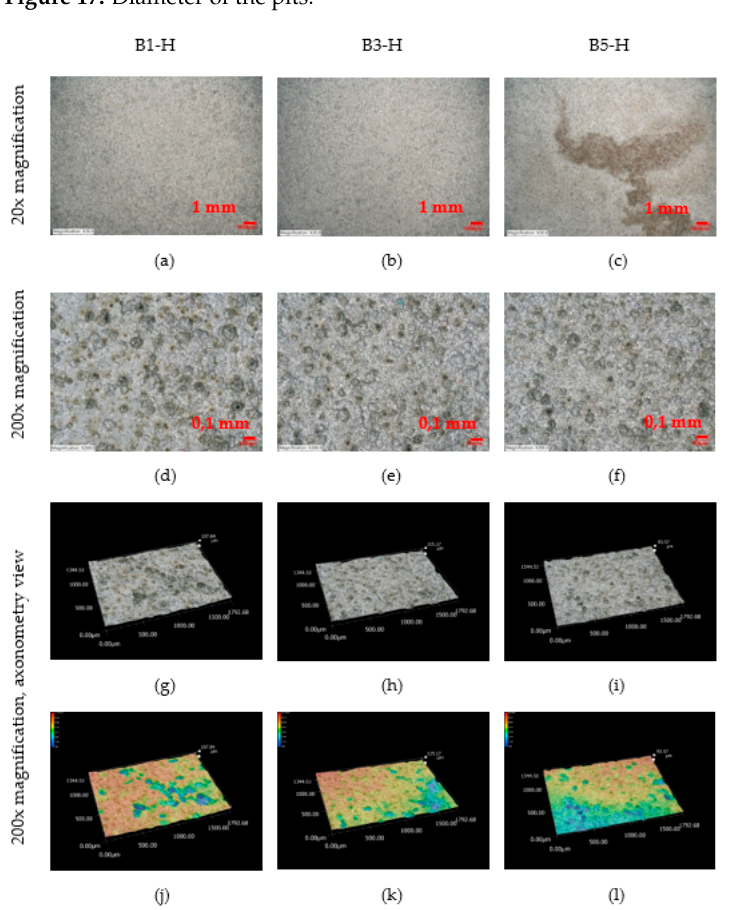
Figure 18. ( a–l ) Structure of the steel surfaces under the corrosion layer—horizontal exposure. An observation of the surface after chemical cleaning procedures for removal of corrosion products of the vertical corrosion coupons is shown in Figure 19. A 200 × magnification of the sample and an axonometric view of the surface after chemical cleaning procedures for removal of corrosion products is shown. The size and depth, diameter and number of pits on the vertical corrosion coupons can be observed. Visually, the two surfaces look very similar. This trend is confirmed by the results from the Table 29. The vertical corrosion coupons from sites B3-V and B5-V show very similar average, minimum and maximum values of depth, diameter and number of pits.